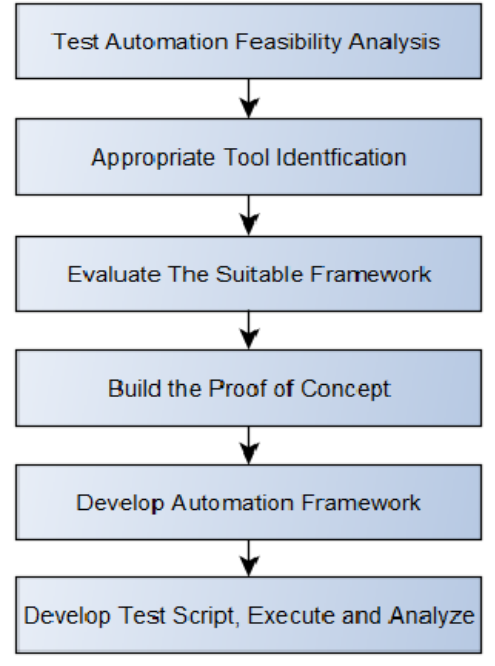
Fig. 5. Overview of the automation testing